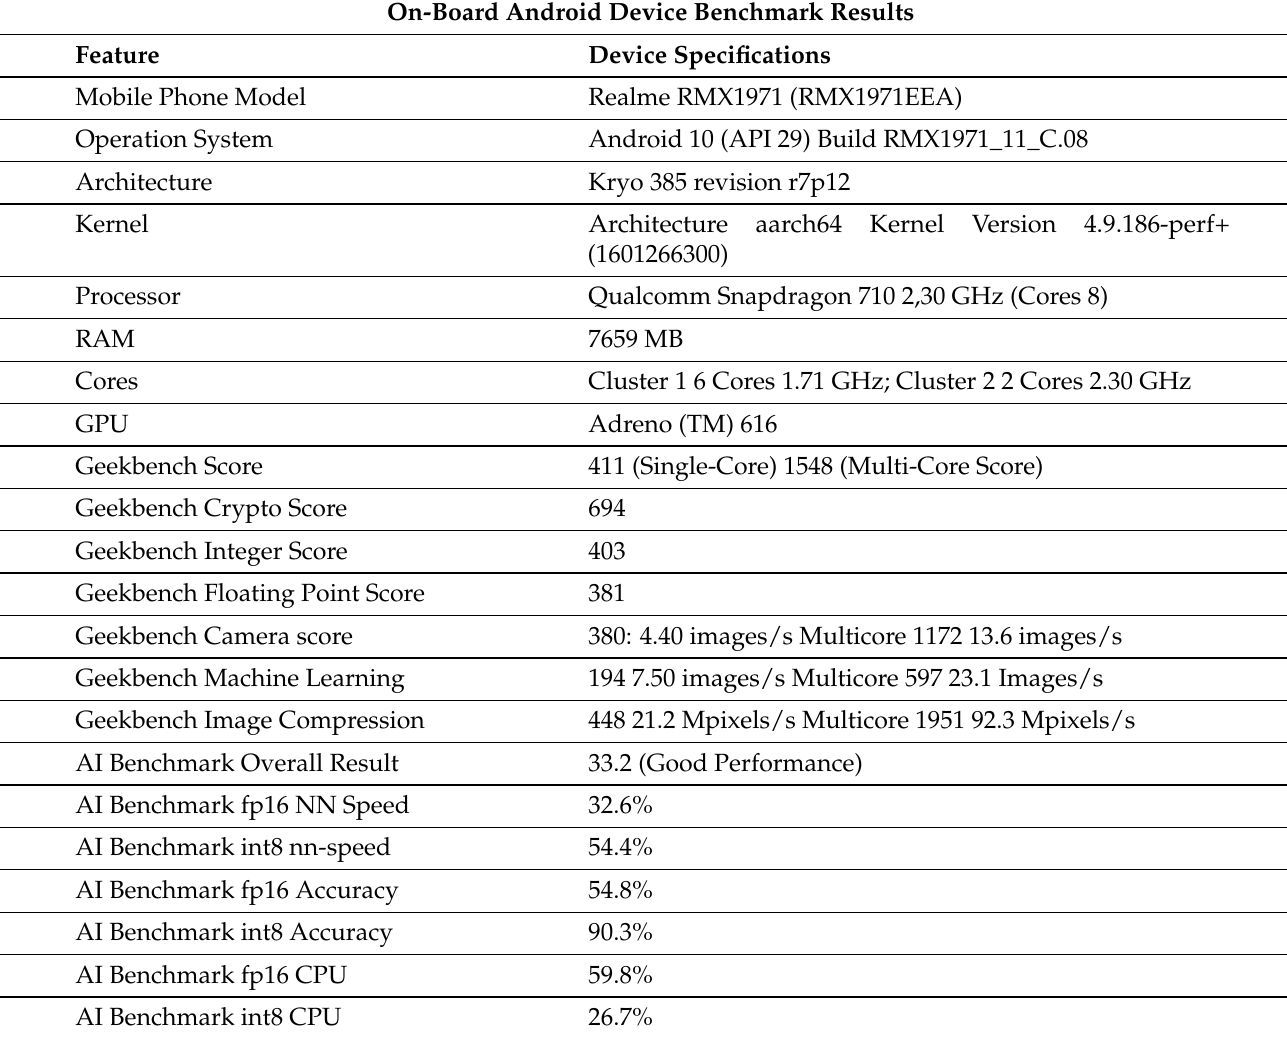
Table 3. On-board Android Device Benchmarking results using CPU-Z, Geekbench, and AI Benchmark application for